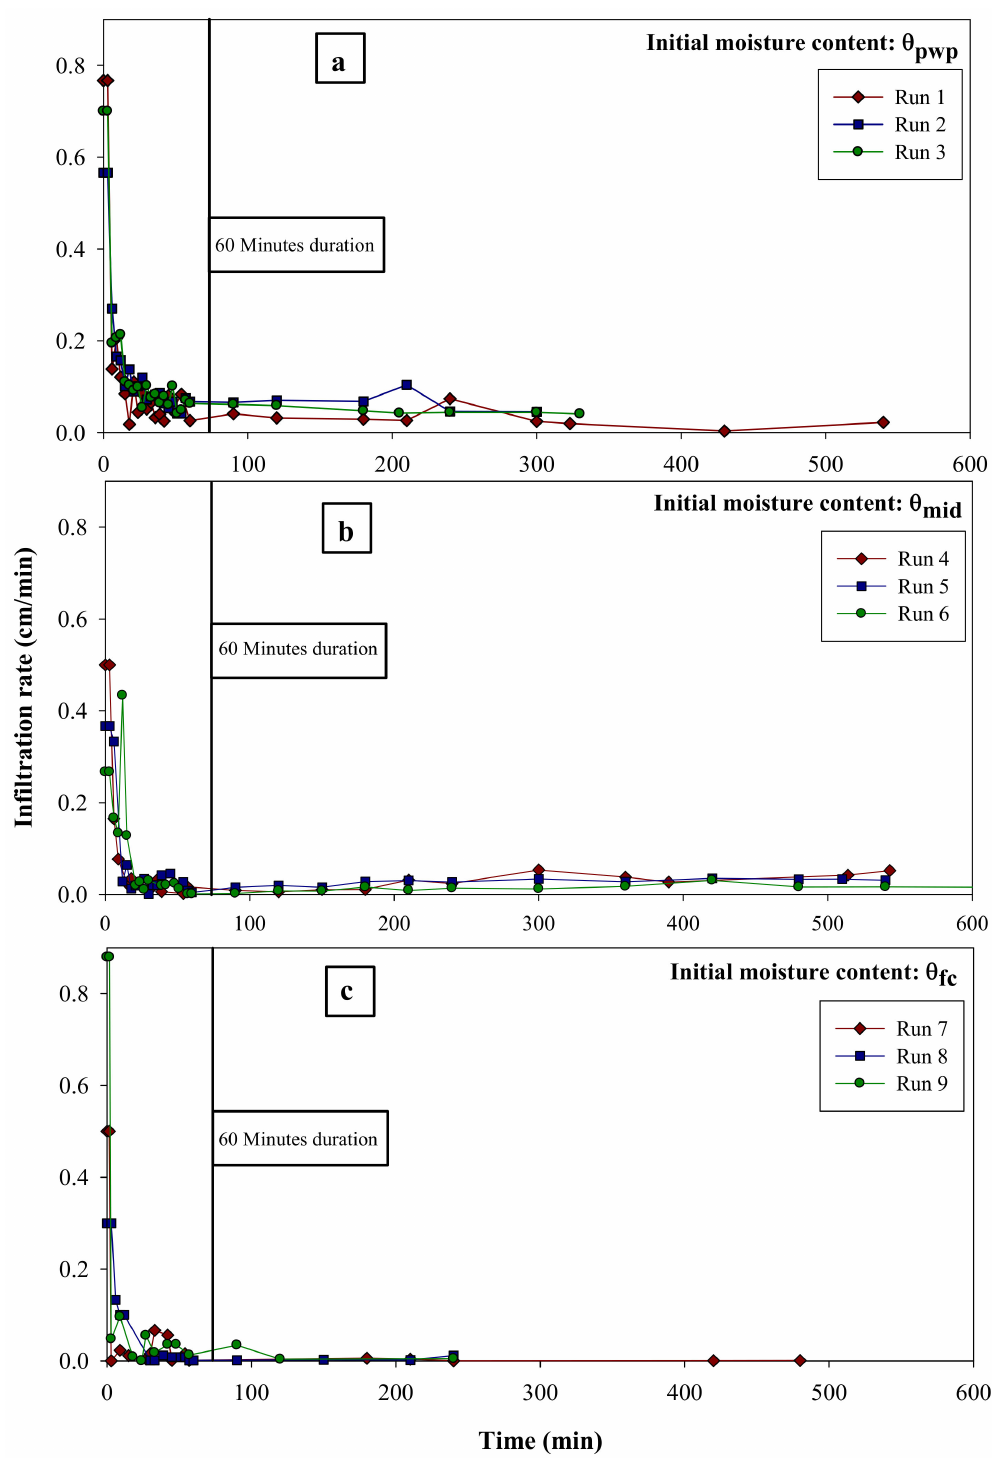
Figure 7. Infiltration rates over total duration of experimental runs, plotted for ( a ) Runs 1, 2, and 3 of initial water content permanent wilting point ( θ pwp ); ( b ) Runs 4, 5, and 6 of initial water content between θ pwp and water content at field capacity ( θ fc ), θ mid ; and ( c ) Runs 7, 8, and 9 of initial water content θ fc